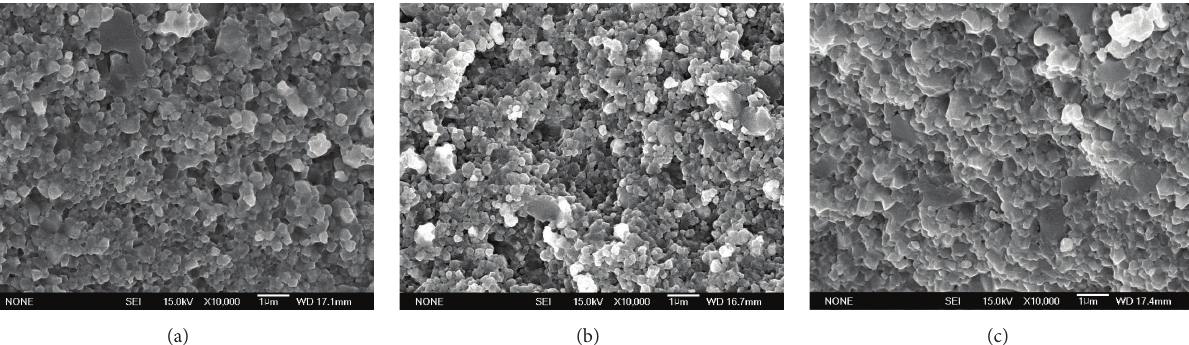
Figure 6: SEM images of the fracture surface of hot-pressed (a) Al 2 O 3 -10wt.% Ni-P, (b) Al 2 O 3 -15wt.% Ni-P, and (c) Al 2 O 3 -20 wt.% Ni-P